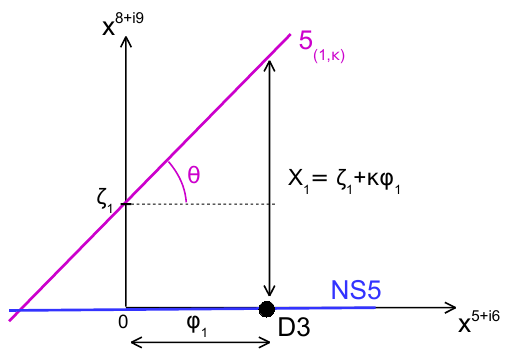
Figure 22 . The 5 brane is moved to the position (cid:16) 1 along x 8+ i 9 , leading to the constraint (1 ;(cid:20) )1 X 1 = (cid:16) 1 + (cid:20)’ 1 (= (cid:16) 1 + (cid:20)’ 2 ). complex plane x 5+ i 6 . The positions (cid:24) complex plane x 8+ i 9 , ordered from left to right ( (cid:24) related to the FI parameters through (cid:17) When m ; m are turned on, the D5 branes are displaced and the D3 segments cannot 1 2 break and move along the D5 directions anymore. This means that the branch III is